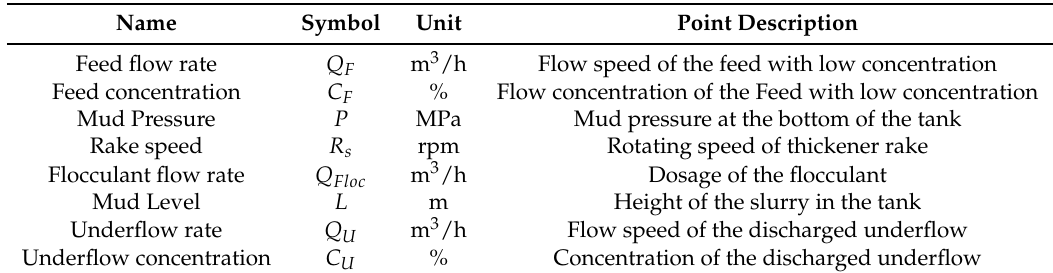
Table 2. Detailed monitoring point list in thickener